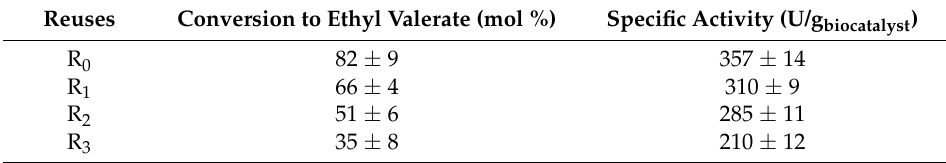
Table 9. Reusability studies of biosilicified enzymes in the esterification reactions using MW radiation. Reuses Conversion to Ethyl Valerate (mol %) Specific Activity (U/g biocatalyst